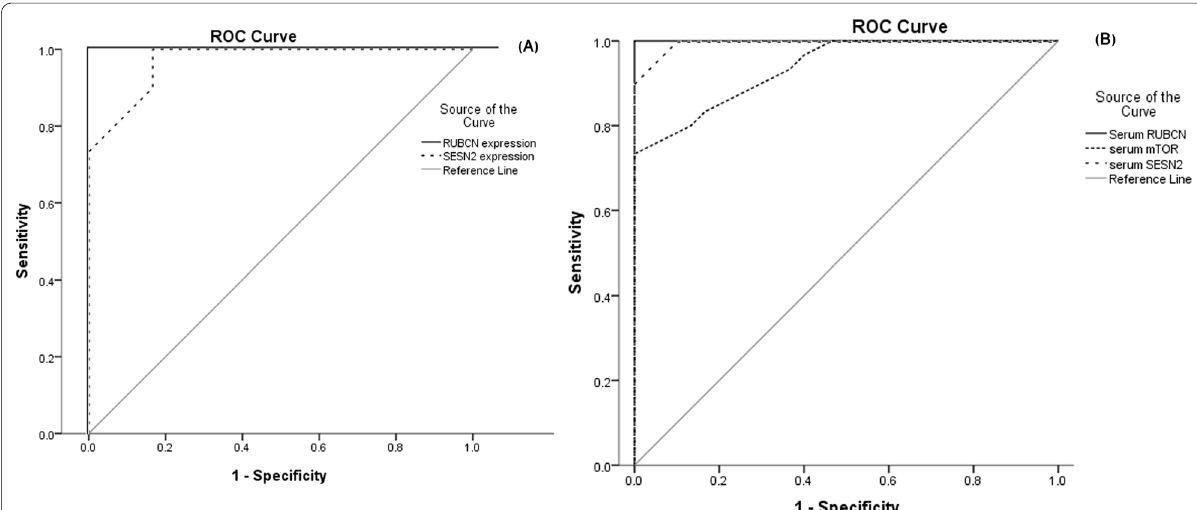
Fig. 1 Receiver operating characteristics curve of the studied proteins and transcripts as biomarkers of Diabetic nephropathy. A ROC curve of RUBCN and SESN2 transcripts as diagnostic biomarkers of diabetic nephropathy. B ROC curve of serum RUBCN, SESN2 and mTOR as diagnostic biomarkers of diabetic